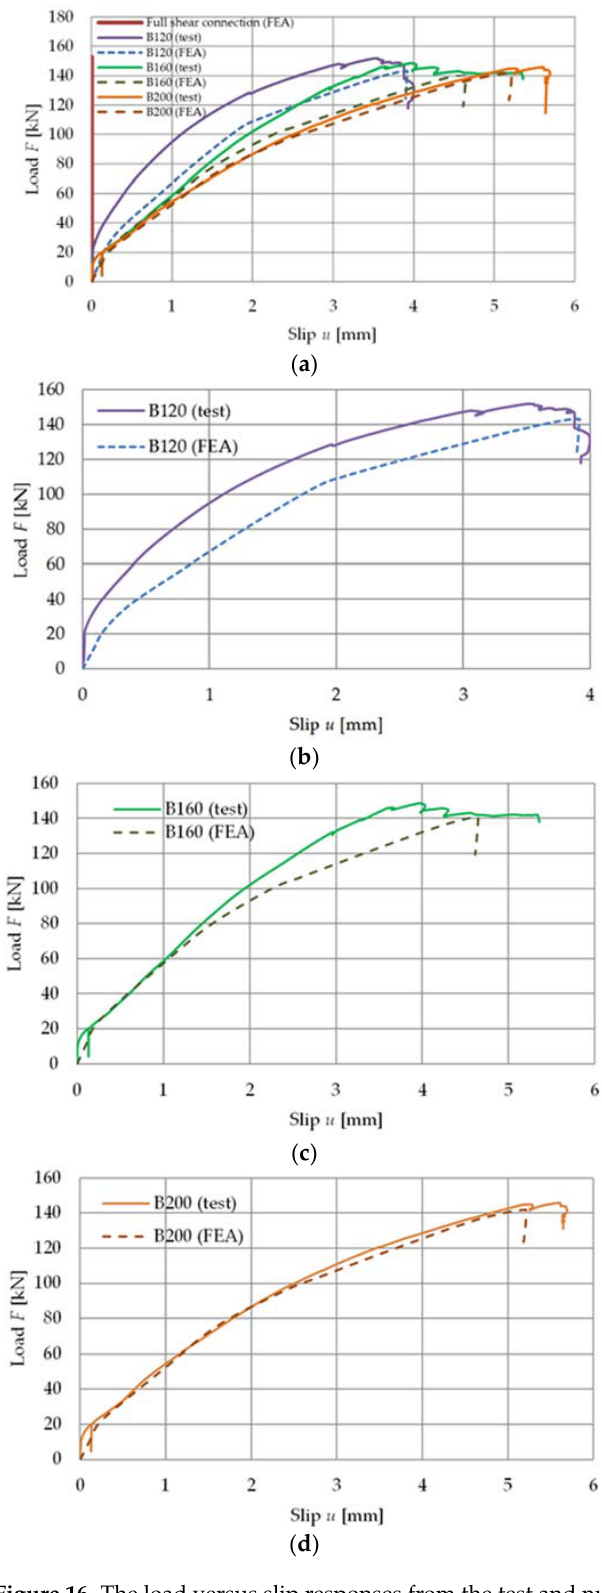
Figure 16. The load versus slip responses from the test and numerical analyses: All curves ( a ), B120 ( b ), B160 ( c ), B200 ( d ).